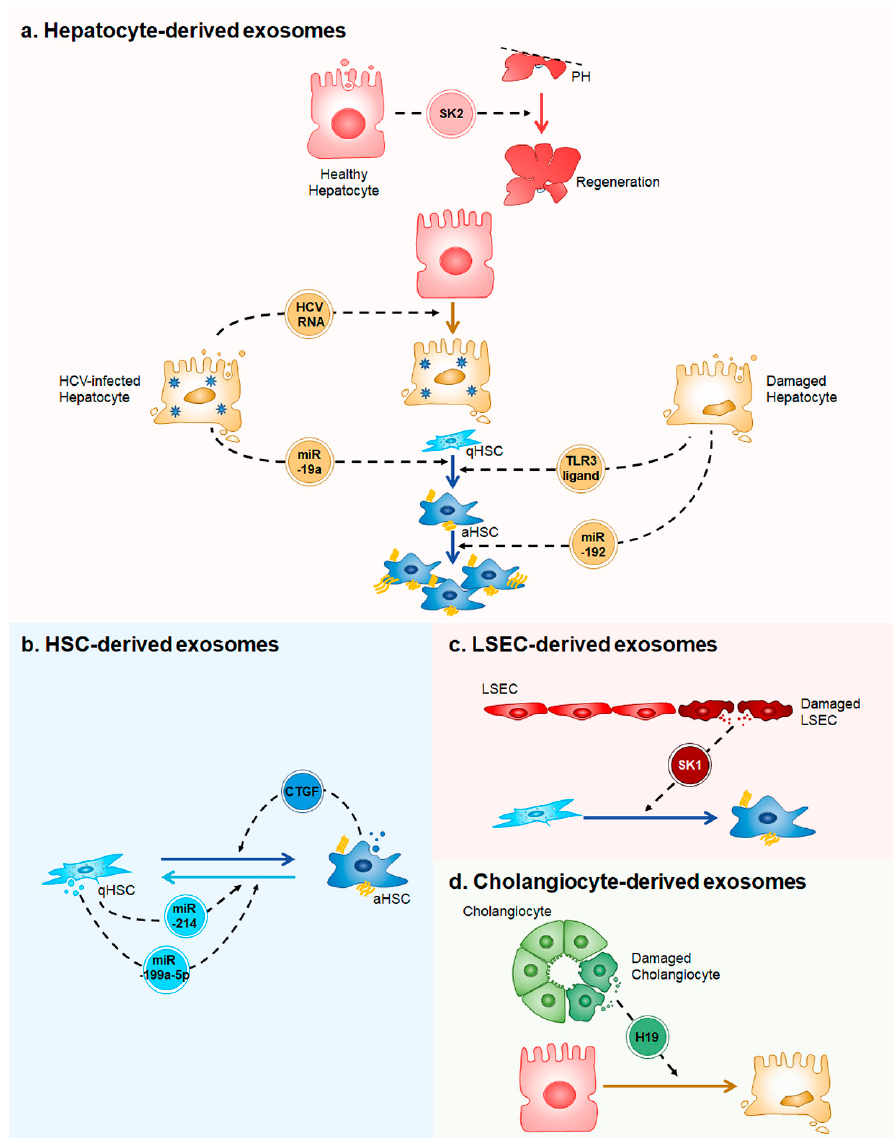
Figure 1. A simplified model of exosome-mediated intercellular communication in the liver. ( a ) Healthy hepatocytes release exosomes containing sphingosine kinase 2 (SK2), which promotes liver regeneration in two-thirds partial hepatectomied (PH) liver. Hepatitis C Virus (HCV)-infected hepatocytes secrete exosomes having HCV RNA to infect the uninfected hepatocytes. MicroRNA (miR)-19a in exosomes derived from the HCV-infected hepatocytes induces trandifferentiation of quiescent hepatic stellate cells (qHSCs) into activated HSCs (aHSCs). When liver is injured, damaged hepatocytes release exosomes containing unknown toll-like receptor 3 (TLR3)-ligands or miR-192. The ligands lead to HSC activation and miR-192 promotes proliferation of aHSCs; ( b ) Exosomes containing miR-214 or miR-199a-5p produced by qHSCs inhibit HSC activation, whereas exosomes having connective tissue growth factor (CTGF) released from aHSCs stimulate HSC activation; ( c ) Injured LSECs release exosomes containing sphingosine kinase 1 (SK1), which induces HSC activation; and, ( d ) Damaged cholangiocytes secrete exosomes containing long non-coding RNA H19 (H19). H19 injuries hepatocytes.